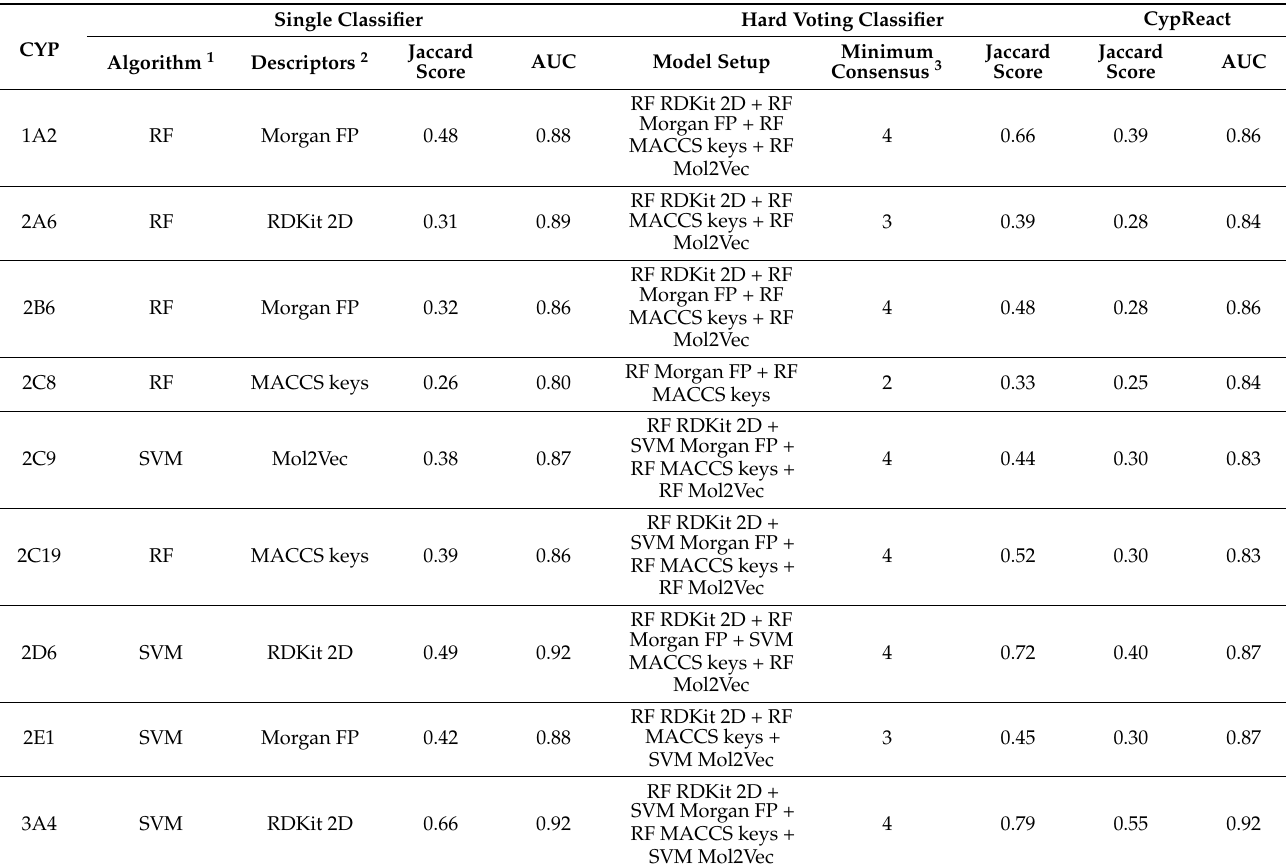
Table 7. Comparison of the performance of the CYPReact models and our best